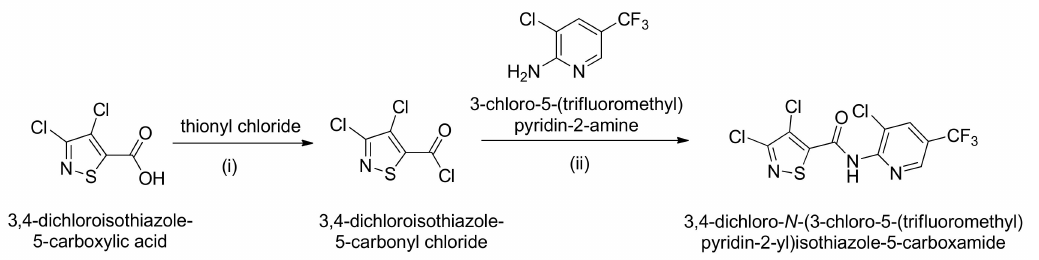
Figure 1. Synthetic route of the compound LY5-24-2. Reagent and conditions: (i) SOCl 2 , reflux, 5